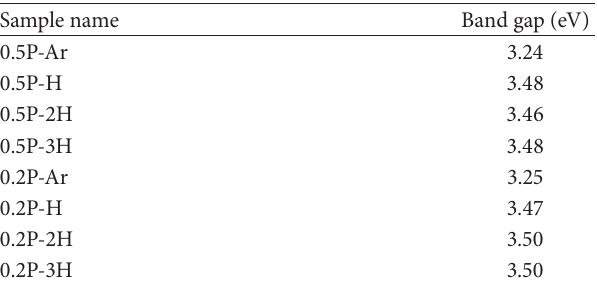
Table 2: The optical band gaps of the films deposited in various sputtering